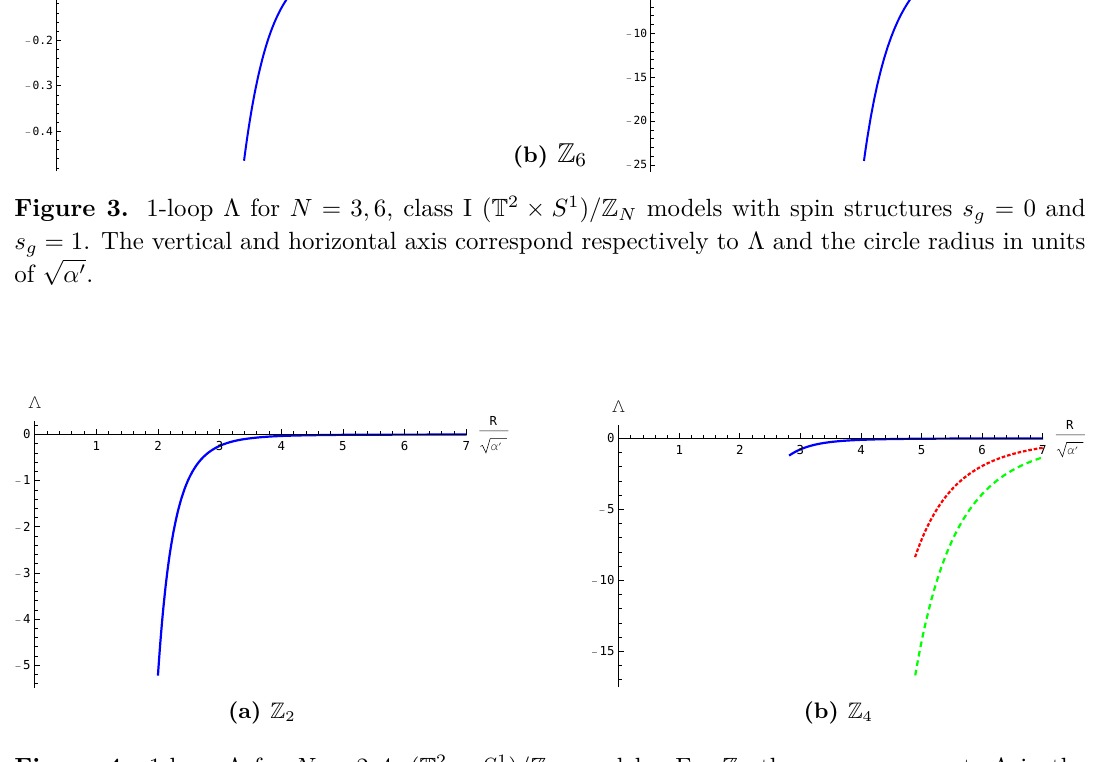
Figure 4. 1-loop Λ for N = 2 , 4 , ( T 2 × S 1 ) / Z N models. For Z 2 the curve represents Λ in the class I model with s g = 0 . For Z 4 , solid blue, the large dashed green and short dashed red curves correspond respectively to class I s g = 0 , class I s g = 1 and class II with ( s 1 , s 2 ) = (1 , 1)